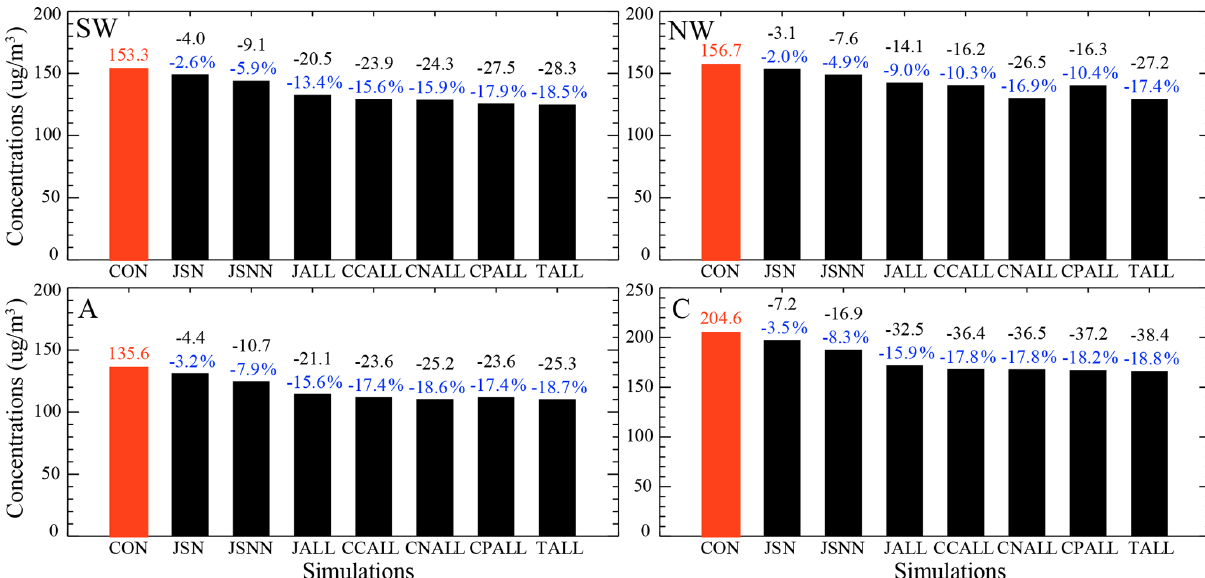
Figure 12. Modeled concentrations (µg / m 3 ) of PM 2 . 5 at Jingzhou in the GEOS-Chem control (red bar) and sensitivity (black bar) simulations for emission reduction and the differences (black numbers show mass concentrations; blue numbers show mass percentages) between the sensitivity and the control simulations. The abbreviations of each simulation are given in Table